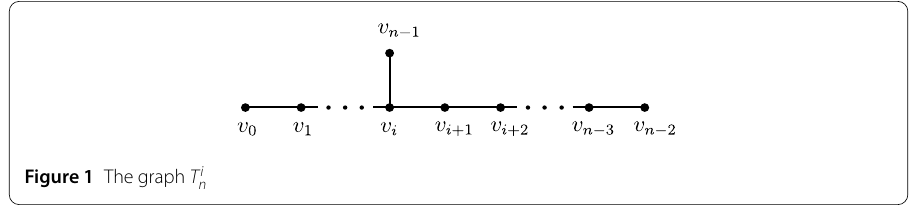
Figure 1 The graph T i n